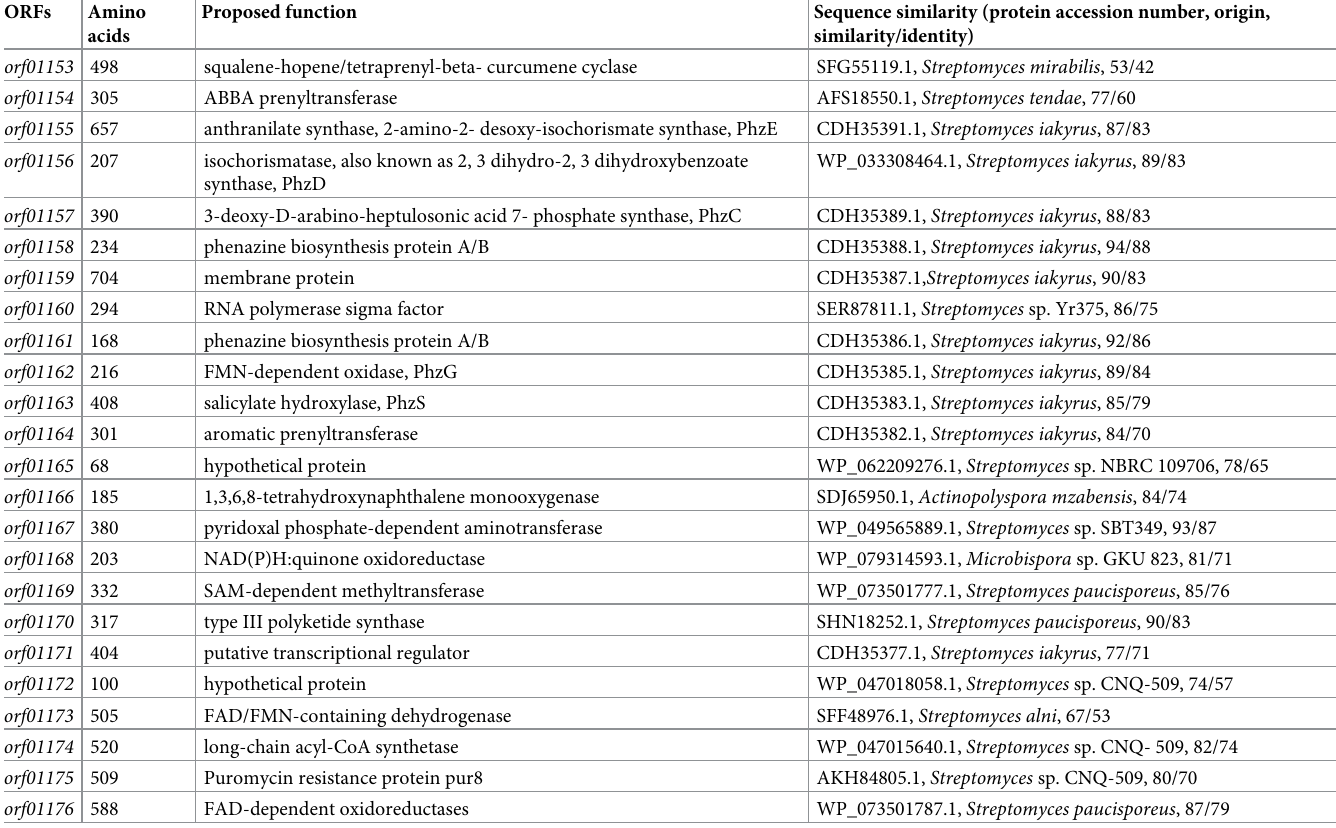
Table 3. Deduced function of the open reading frames in Fig 3.